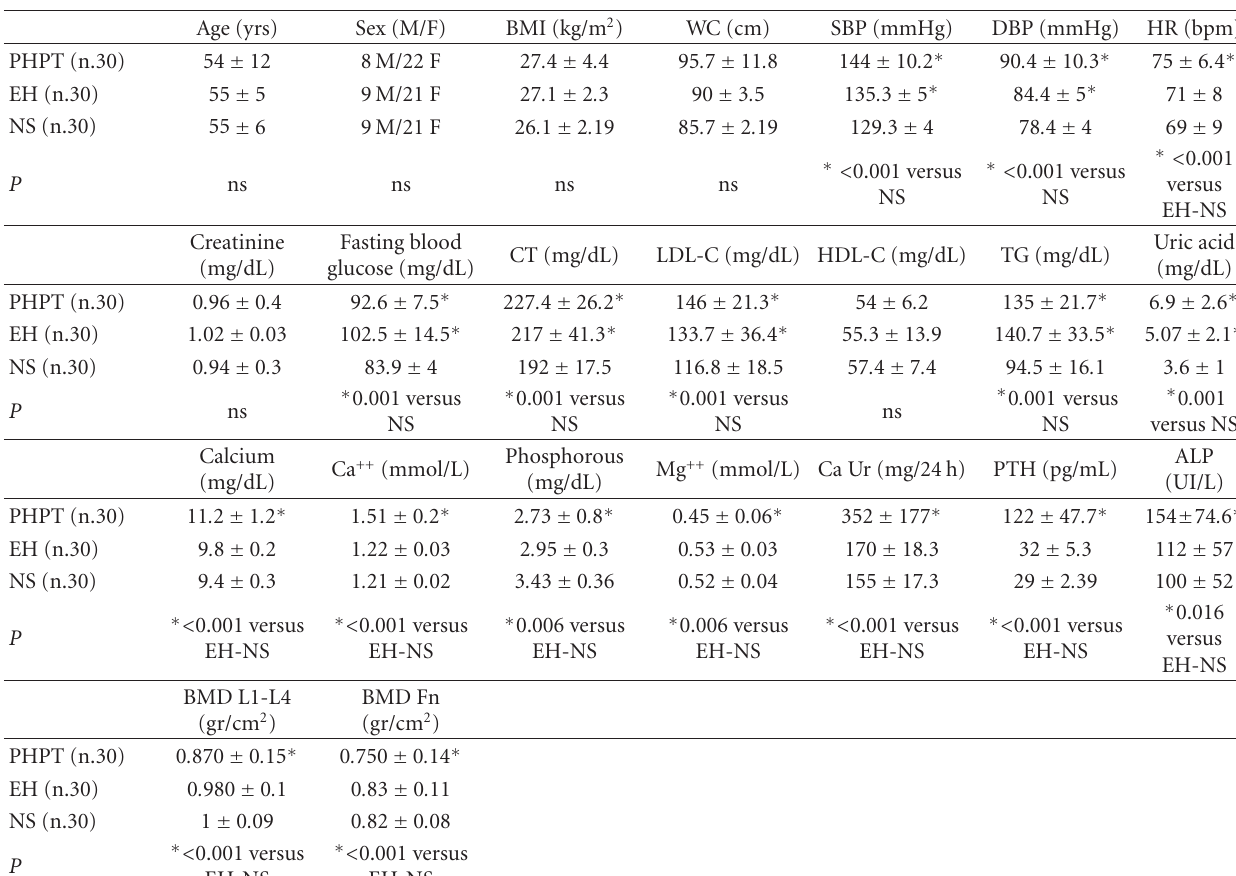
Table 1: Demographic, biochemical, calcium-phosphorus mineral metabolism, and bone mineral density in studied groups.